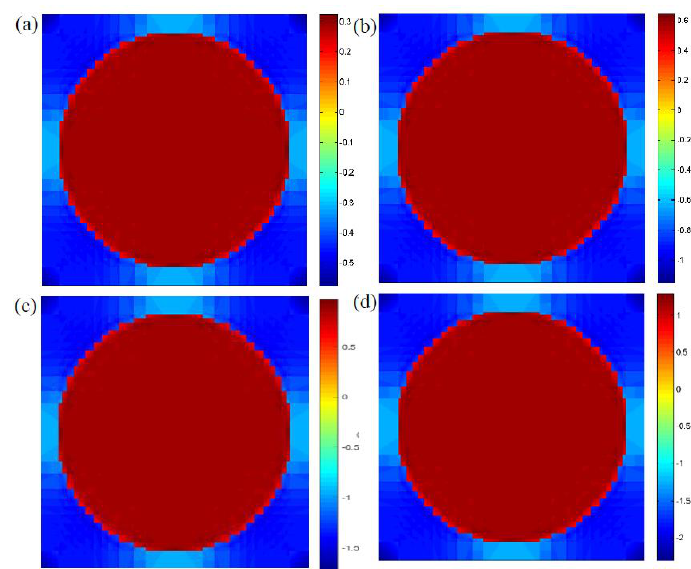
 of the RVE under different ambient temperatures: ( a ) Figure 8. Microscopic stress distributions 11 Figure 8. Microscopic stress distributions σ 11 of the RVE under di ff erent ambient temperatures: